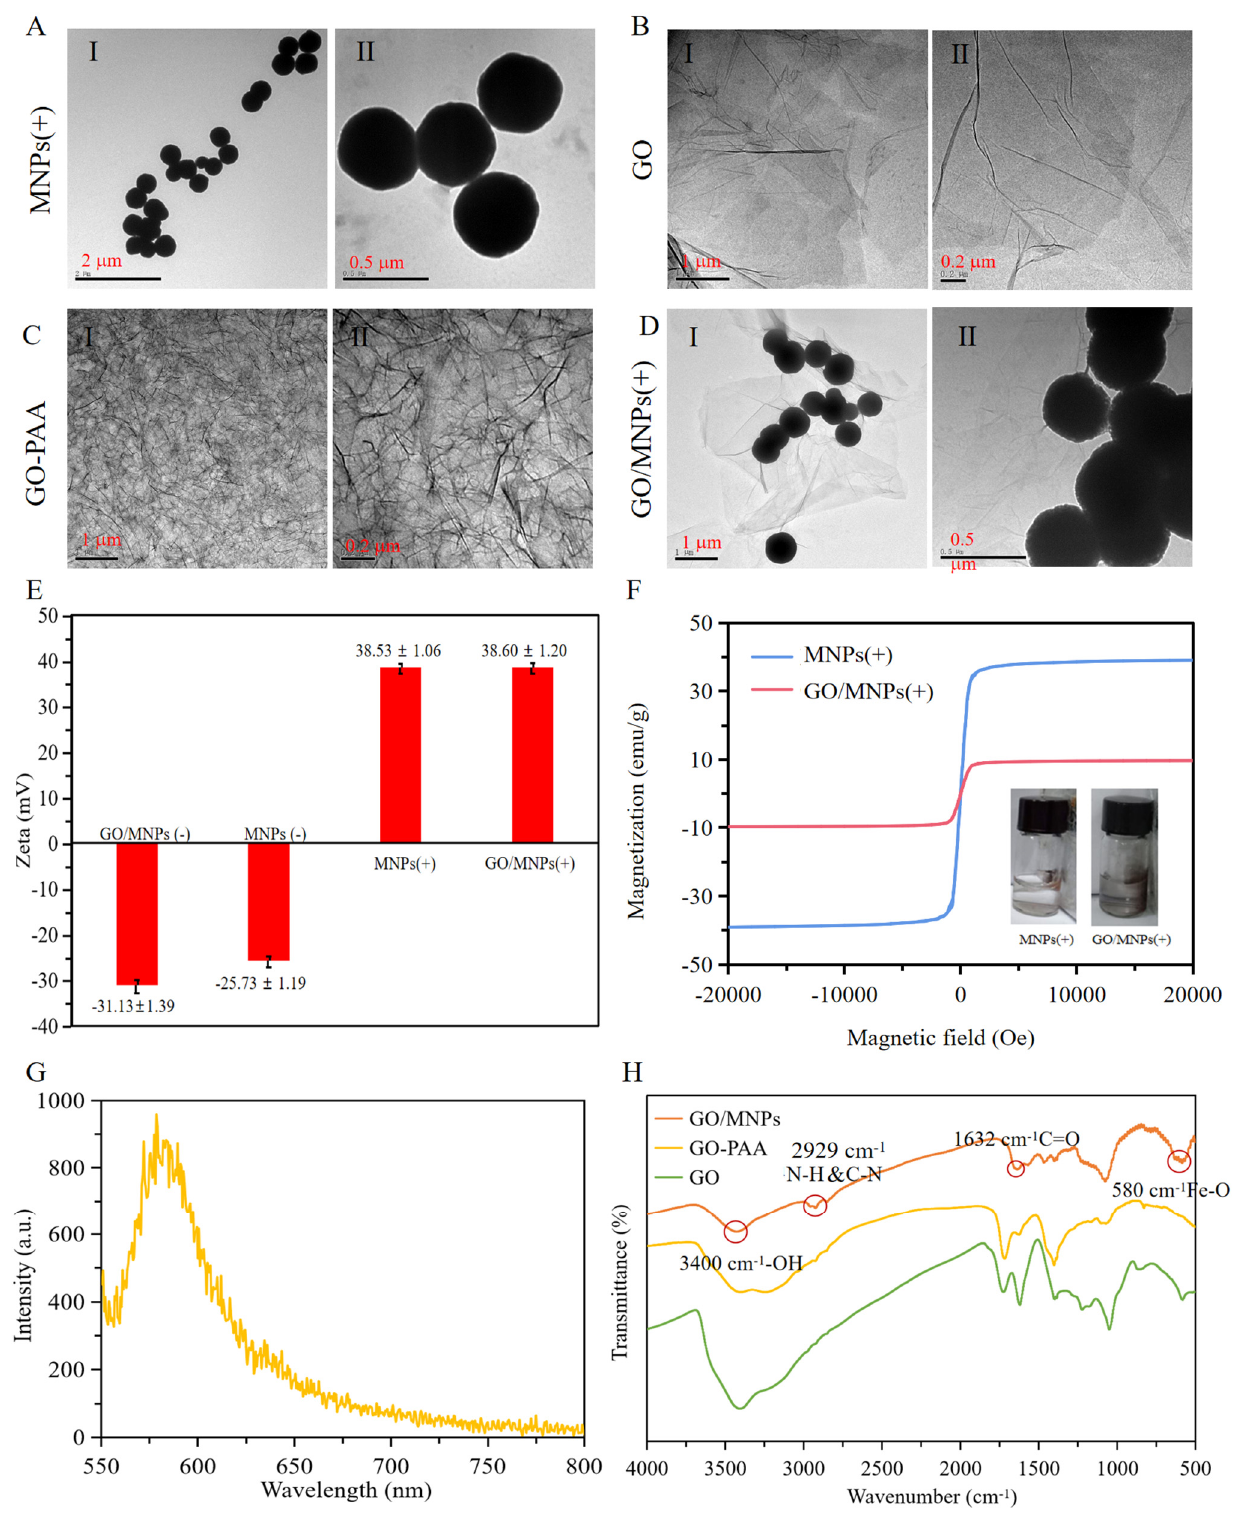
Figure 2. Characterization of electrophysiological nanoprobes. TEM images of ( A ) MNPs(+); ( B ) GO; ( C ) GO-PAA; ( D ) GO/MNPs(+); ( E ) Zeta potential of nanoprobes in an aqueous solution; ( F ) magnetic properties and hysteresis loops of MNPs(+) and GO/MNPs(+); Magnetization curve of both MNPs(+) and GO/MNPs(+) obtained through a VSM; The curve shows the superparamagnetism of both MNPs(+) and GO/MNPs(+); ( G ) fluorescence spectra of GO/MNPs; ( H ) infrared spectra of GO, GO-PAA and GO/MNPs.